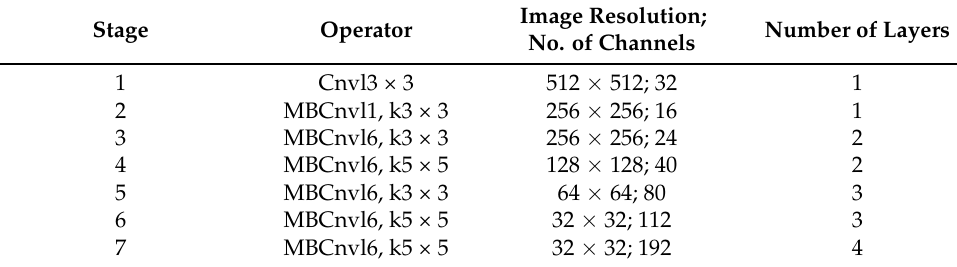
Table 2. EfficientNet-B0 parameters used in proposed